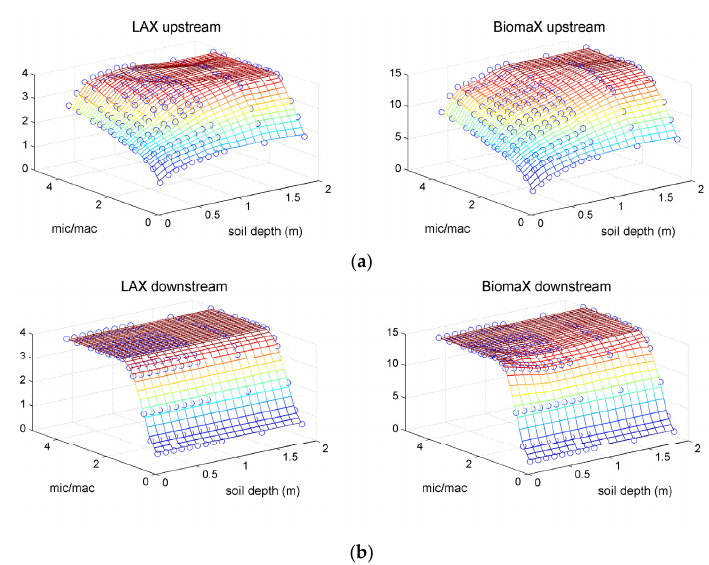
Figure 3. Sunflower maximum of LAI (LAX) and biomass (BiomaX in t/ha) sensitivity to soil parameters for the year 2006: retention/drainage porosity ratio (mic/mac) and soil depth, for a pixel located in upstream area ( a ); and downstream area ( b ). Each blue circle corresponds to a TNT2 simulation.